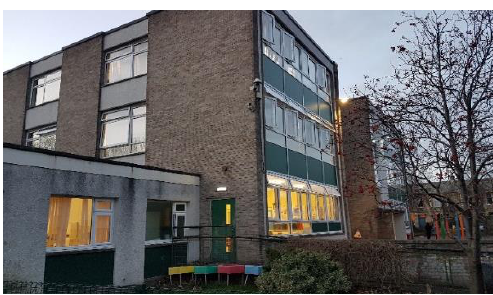
Figure 3. Picture of classroom A2.